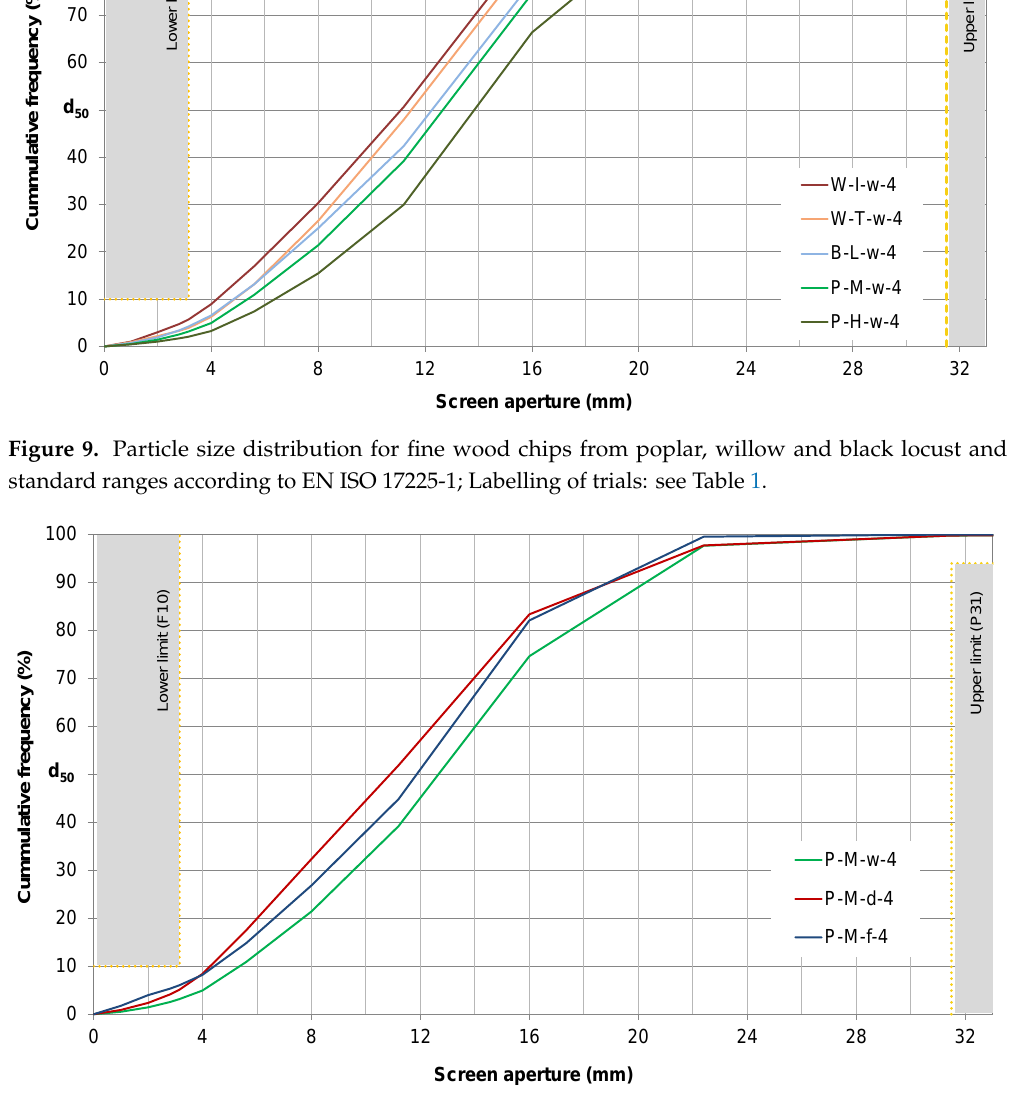
Figure 10. Particle size distribution for fine wood chips from fresh, dried and frozen poplars (variety Max) and standard ranges according to EN ISO 17225-1; Labelling of trials: see Table 1.